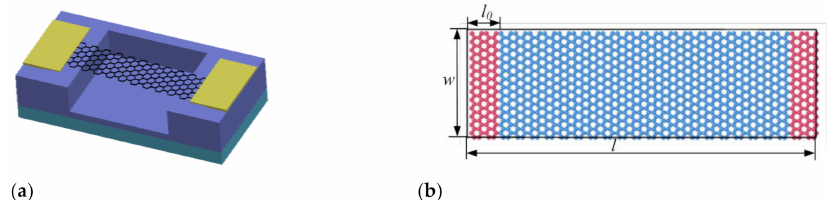
Figure 2. Schematic diagram of graphene nanoribbon model, ( a ) Schematic diagram of double-end solid-supported graphene resonator structure, ( b ) Schematic diagram of graphene resonant